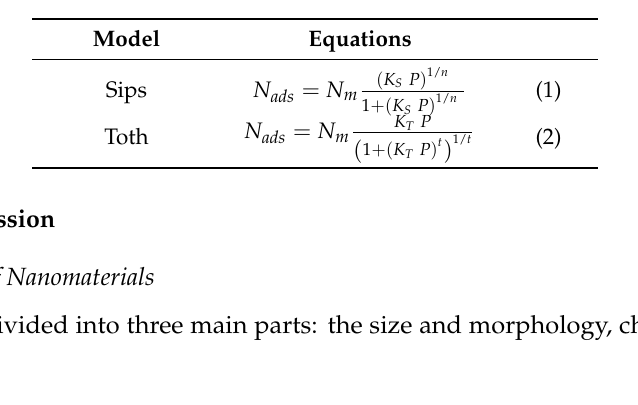
Table 2. Models for adsorption